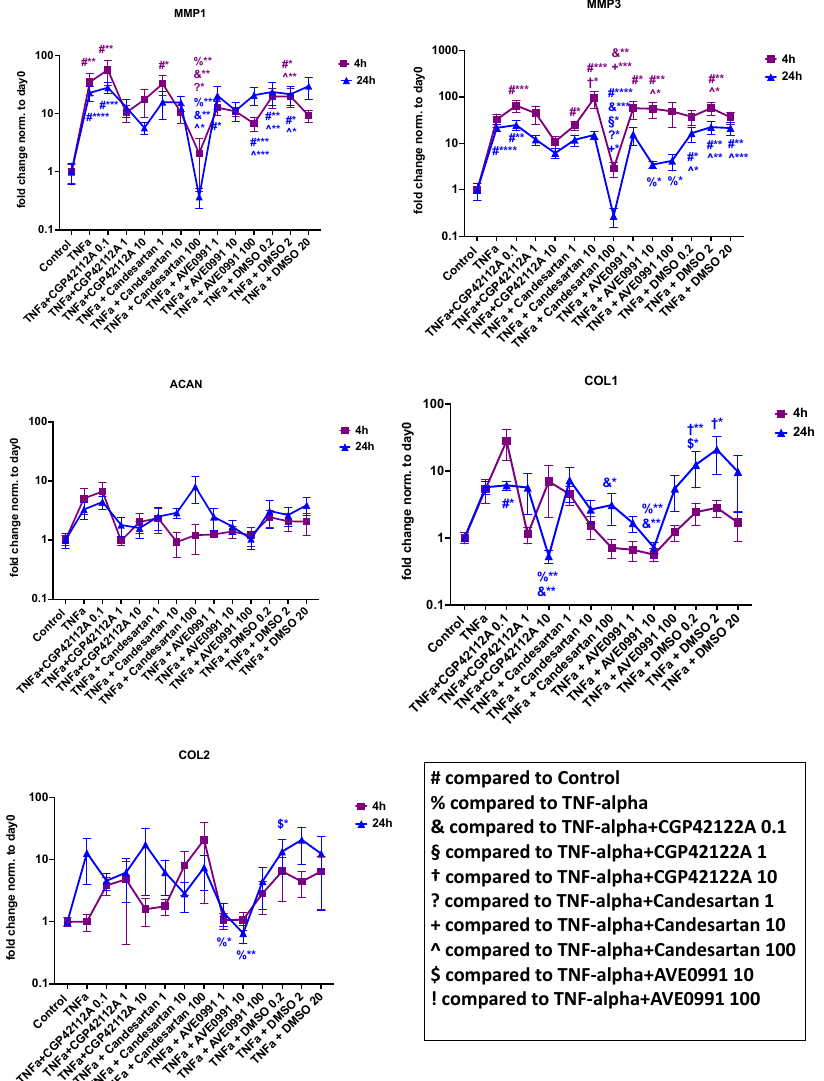
Figure 7. Gene expression analysis of tissue-degenerative and phenotype-modulating markers in human NP cells for candesartan (1 µ M, 10 µ M, 100 µ M), the MAS-receptor agonist AVE 0991 (1 µ M, 10 µ M, 100 µ M), and the AGTR2-receptor agonist CGP-42112A (0.1 µ M, 1 µ M, 10 µ M) with 4 h and 24 h of exposure in inflammatory settings (TNF- α addition). DMSO (0.1 µ L/mL, 1 µ L/mL, 10 µ L/mL; shown in µ L volume on the x -axis) was used as the solvent control. Fold change values normalized to the baseline (day 0) are shown. n = 4 biological replicates and n = 3 technical replicates per donor were assessed. Mean and standard error of the mean (SEM) are shown. * p < 0.05; ** p < 0.01; *** p < 0.001; **** p < 0.0001.